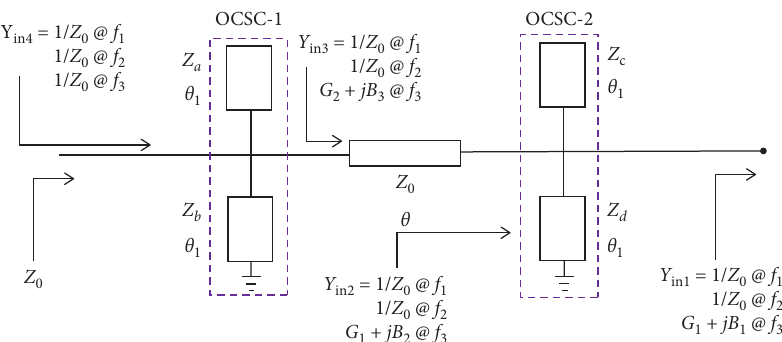
Figure 23: Block diagram of the Dual-to-Triband Impedance Transformer (DTBT).